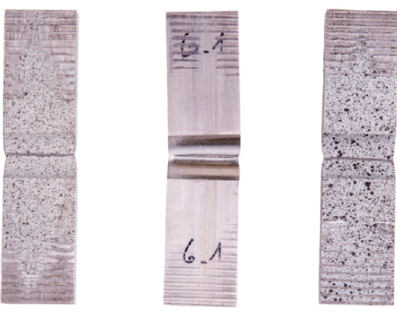
Figure 8. Shear test specimens.